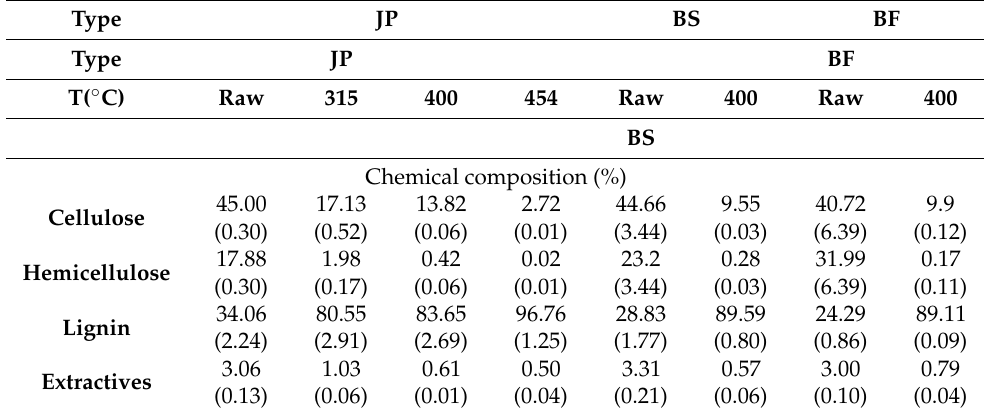
Table 2. Chemical composition of untreated- and treated-wood